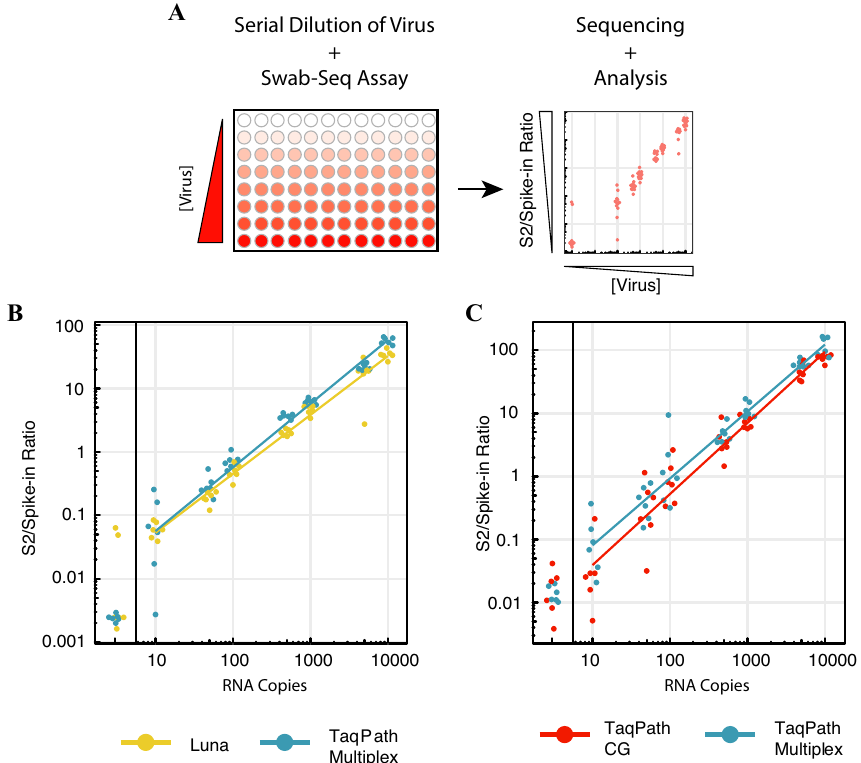
Figure 1. Implementation of Swab-Seq. ( A ) Schematic of initial QC experiments for implementing Swab-Seq. Synthetic RNA or inactivated virus is added to a 96-well plate at specified concentrations and then processed through the Swab-Seq assay. After sequencing the libraries, the S2/Spike-in ratio is compared to the loaded amount of viral material to determine the analytical sensitivity and robustness of the assay. ( B ) Comparison of Luna and TaqPath Multiplex 1-step RNA kits used in the assay. ( C ) Comparison of TaqPath Multiplex and TaqPath CG kits. In ( B ) and ( C ), black vertical lines partition 0 copies of virus from the serial dilutions. Each dot is an individual well of a plate with the specified concentration. The colored lines are least-squares fitted lines incorporating all non-zero data points.